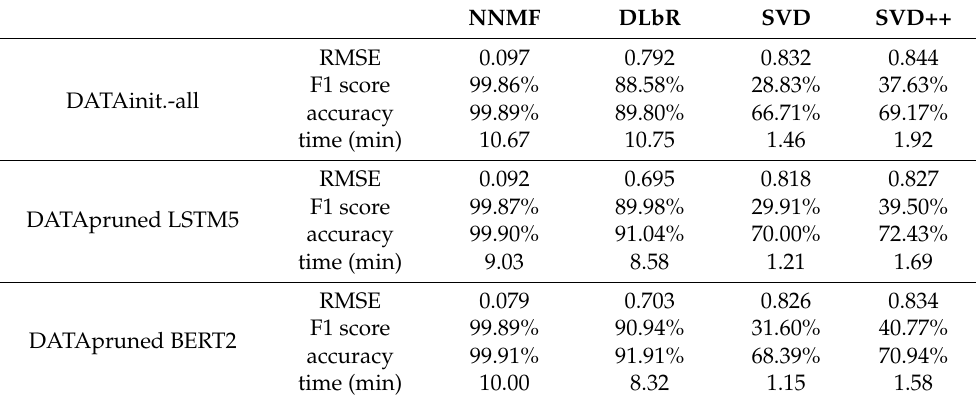
Table 9. Results achieved per each model with three datasets generated from Kindle Store.